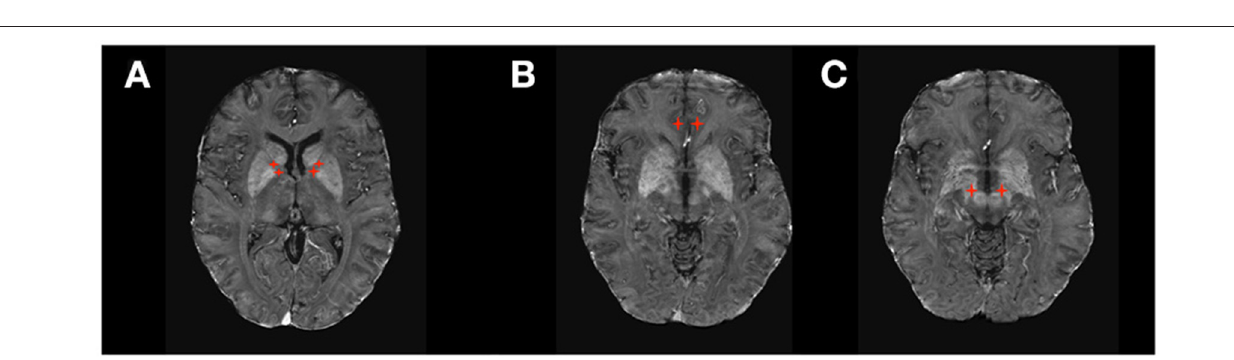
FIGURE 3 | DBS targets in Psychiatry. (A) Ventral Capsule/Ventral Striatum (VC/VS) and Anterior Limb of the Internal Capsule (ALIC); (B) subcallosal cingulate gyrus including Brodmann area 25 (SGC25); (C) Subthalamic Nucleus (STN).